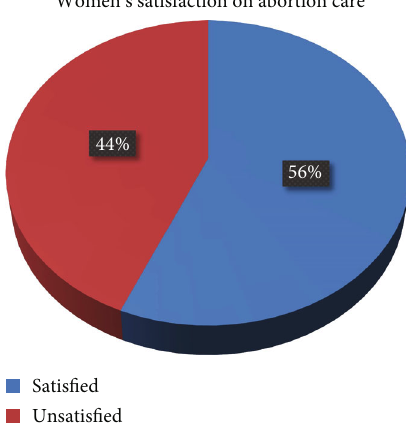
Figure 2: Women satisfaction with abortion service and associated factors among clients who received the service in public health facilities of Mojo town.